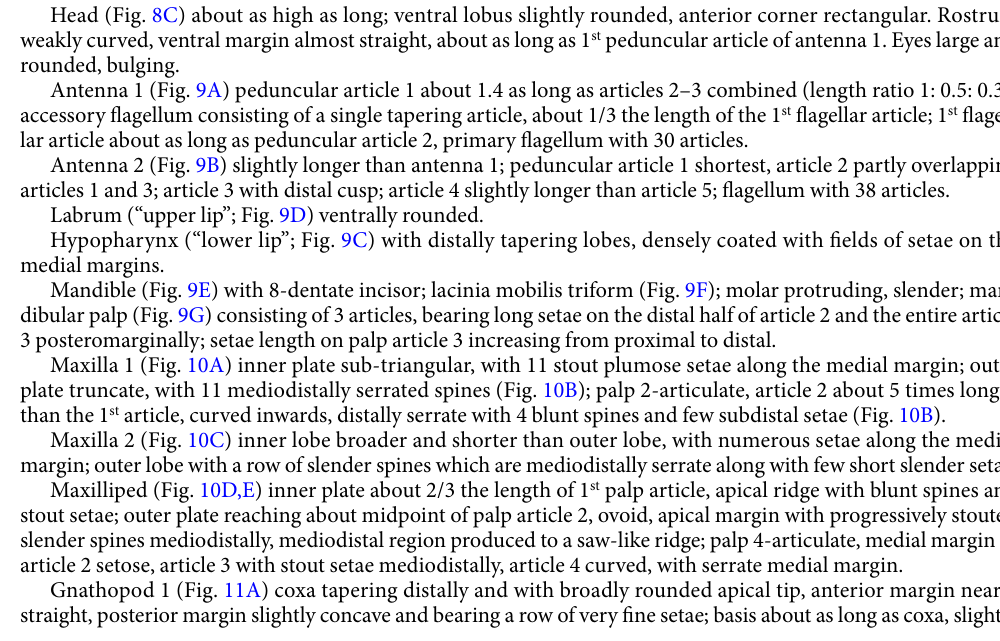
Figure 13. Epimeria frankei sp. nov., holotype, adult female, northern North Sea, NHMUK 2015.3264: ( A ) pereopod 6, ( B ) left pereopod 7, ( C ) right coxa 7, ( D ) uropod 1, ( E ) uropod 2, ( F ) uropod 3, ( G ) telson; Epimeria frankei sp. nov., paratype, adult male, northern North Sea, NHMUK 2015.3267: ( H ) lateral habitus; Epimeria frankei sp. nov., adult female, Mediterranean Sea, MCSN Ec1: ( I ) lateral habitus; scales: (A,B,D,E,F,H,I) 1 mm; (C,G) 0.5